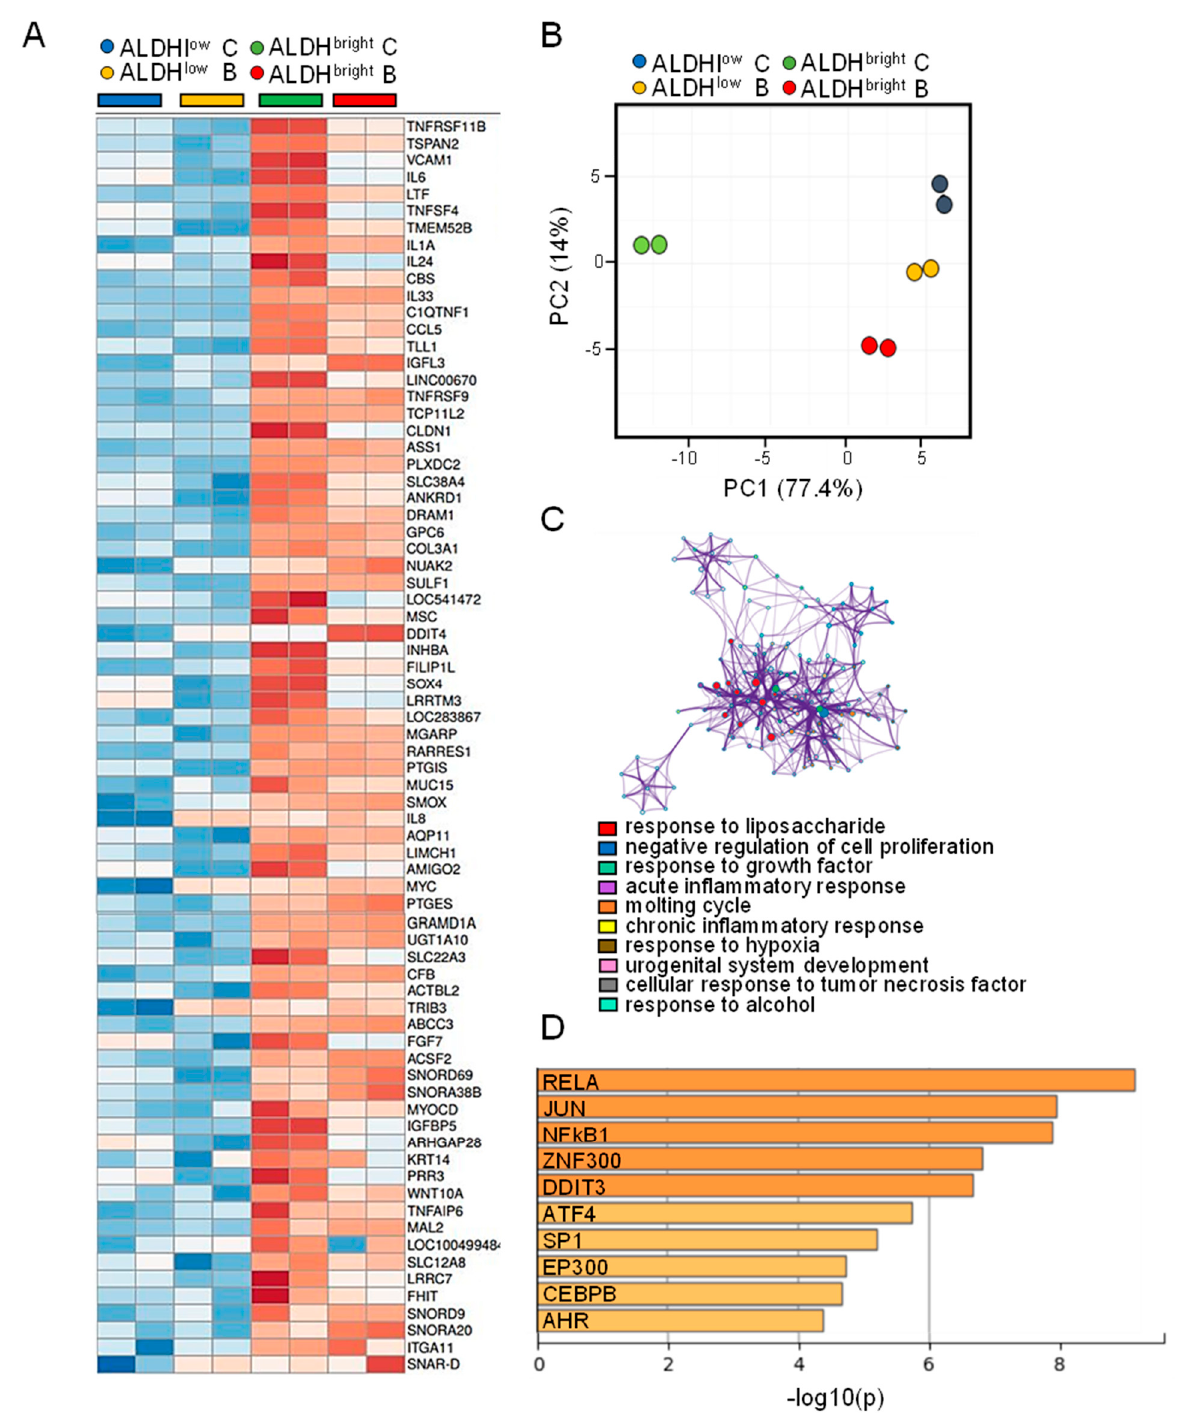
Figure 3. Analysis of the genes enriched in ALDH bright cells: ( A ) representative heat map of the genes significantly enriched in the ALDH bright cells (when compared to ALDH low cells). Log2 (expression). p < 0.05, ≥ two-fold enriched mRNAs. ( B ) PCA plot showing the distribution of the cell subpopulations based on the levels of expression of the genes in ( A ). ( C ) Upper panel. The top 10 enriched GO terms between the groups with p < 0.05 were considered as enriched. The protein–protein interaction network: each term is represented by a circle node, with size proportional to the number of input genes. Lower panel. List of the most significantly enriched pathways as from upper panel. ( D ) Histogram showing the most significantly enriched binding sites ( p < 0.05) within the promoters of the analyzed genes.